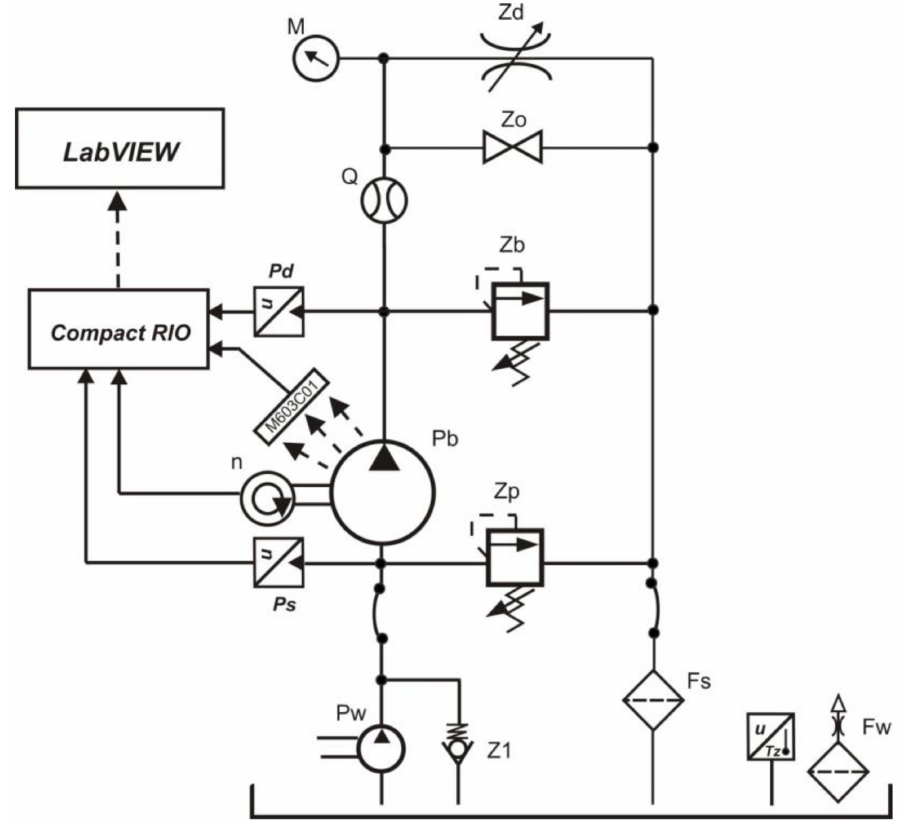
Figure 3. Simplified diagram of the test bench: Pb—multi-piston pump being tested, Pw—booster pump, Zb—maximum valve, Zp—bypass valve, Zd—throttle valve, Zo—shut-off valve, Z1—non- return valve, Fs—low-pressure filter, Fw—filler filter, M—pressure gauge, n—rotometer, Q—flow meter, Ps —static pressure transducer, Pd —dynamic pressure